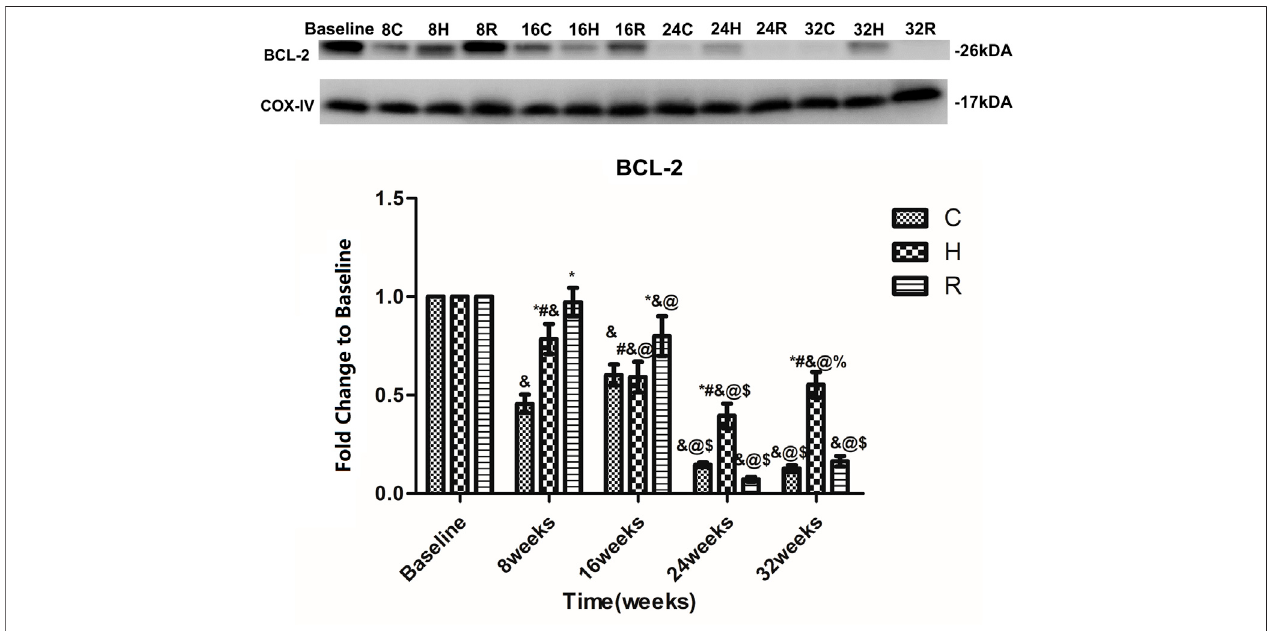
FIGURE 5 | Age and exercise training effects on Bcl-2 levels in mitochondria of soleus muscle, were evaluated by Western blot. * Signi fi cant different from C and othergroup;#Signi fi cantdifferentfromHandR;&Signi fi cantdifferentfromBaselineandotherweeks;@Signi fi cantdifferentfrom8weeksandotherweeks;$Signi fi cant different from 16 weeks and other weeks; % Signi fi cant different from 24 weeks and other weeks. ( p < 0.05).